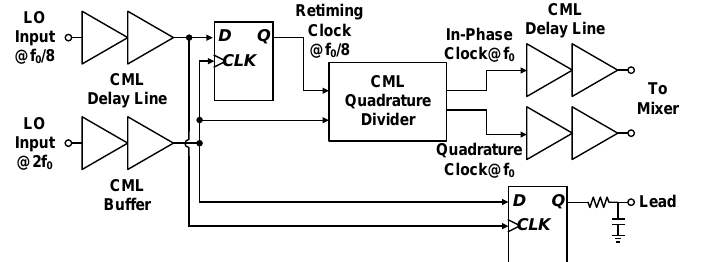
Figure 11. Simplified block diagram of the proposed quadrature clock generation